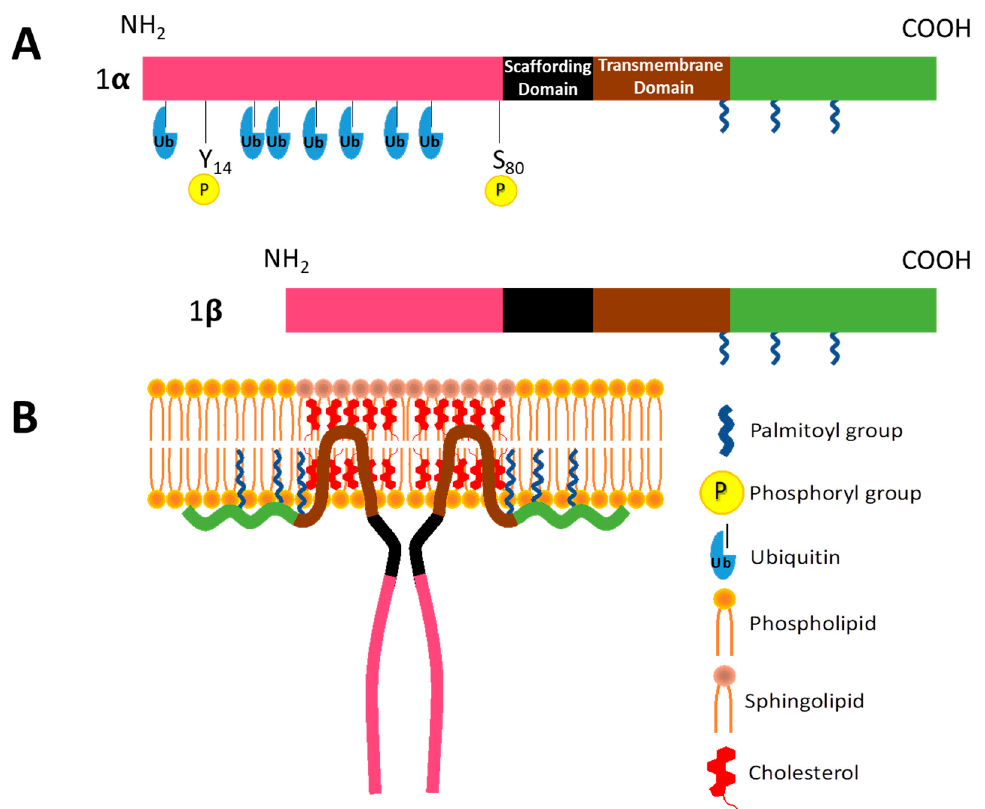
Figure 2. Proposed structure of Caveolin-1 (CAV1). ( A ) Schematic of CAV1 α highlighting different domains and posttranslational modifications, including phosphorylation on tyrosine 14 and serine 80, ubiquitination of N-terminal residues and carboxyterminal palmitoylation sites. Simplified schematic for the β isoform. ( B ) CAV1 α without amino-terminal modifications partially inserted into sphingolipid and cholesterol-enriched regions via hairpin-like membrane insertion domain.